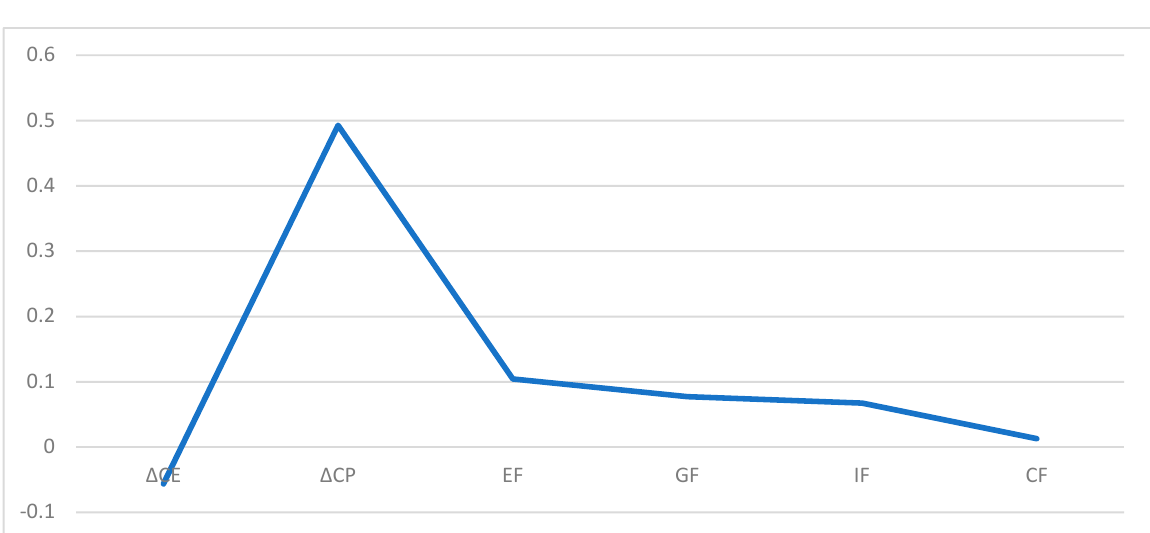
Table 6. Robustness analysis. EASC Pilot